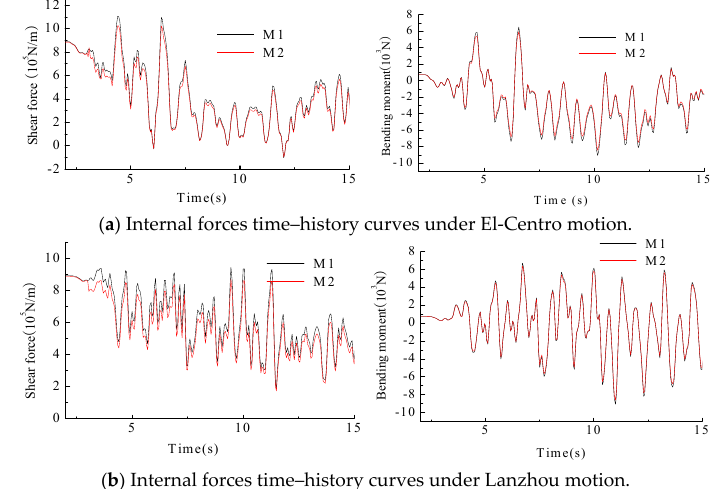
Figure 23. Shear force and bending moment time–history curves in the X-direction at the bottom of side wall 4. Table 12. Peak internal forces of the side wall.